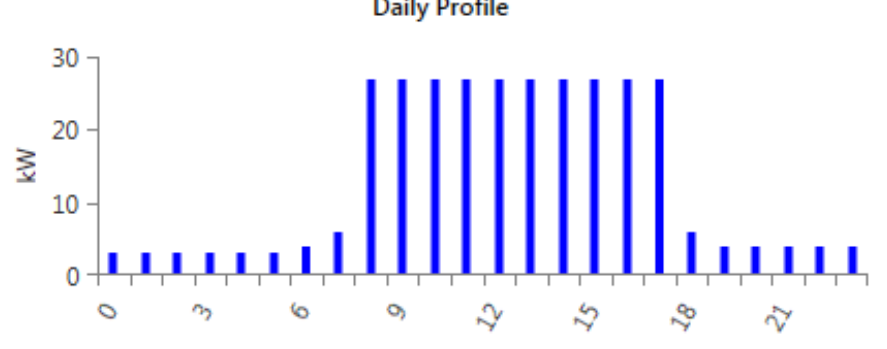
Figure 7. Average daily load within the year.